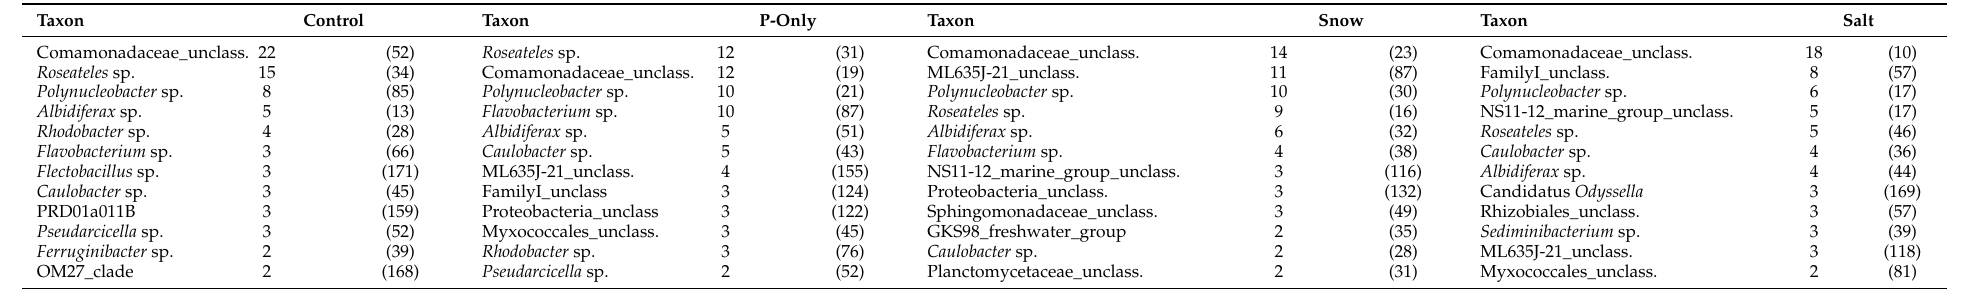
Table 3. The relative abundance (% of total reads) of the twelve most abundant prokaryote taxa (resolved to genus where possible) within each treatment. Each value is the mean of triplicate incubations (SD as the percent mean in parentheses).